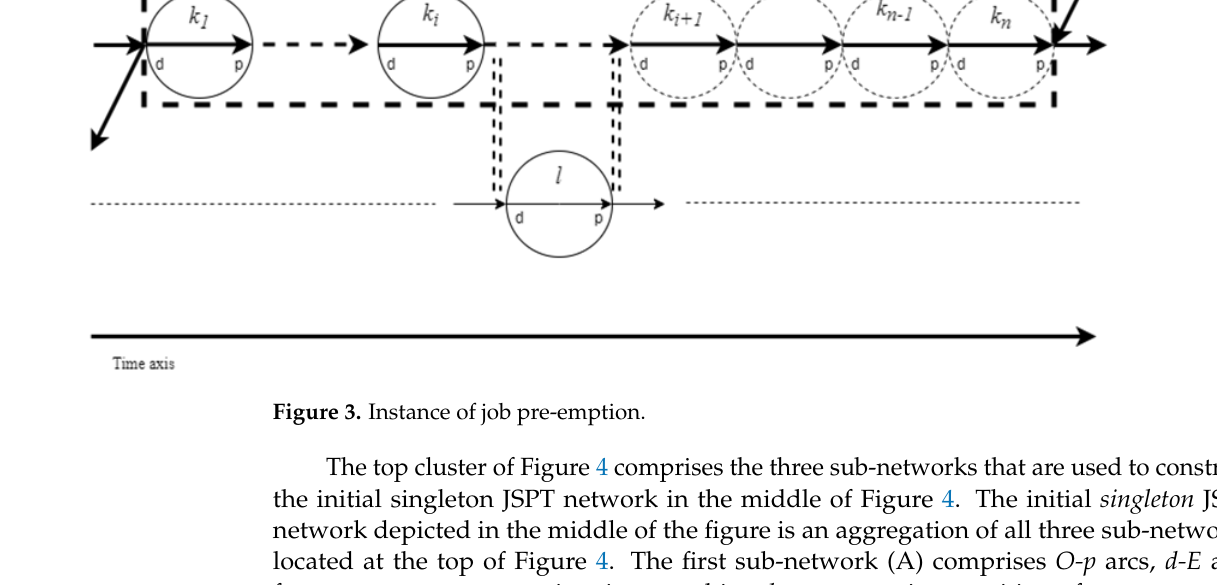
8 of 25 Figure 2. Pre-grouping of machine stations just after network construction ( top ) and post-grouping (alongside removal of extraneous arcs) for model simplification ( bottom ). As duplicate machines of the same origin might be used to process operations of dif-